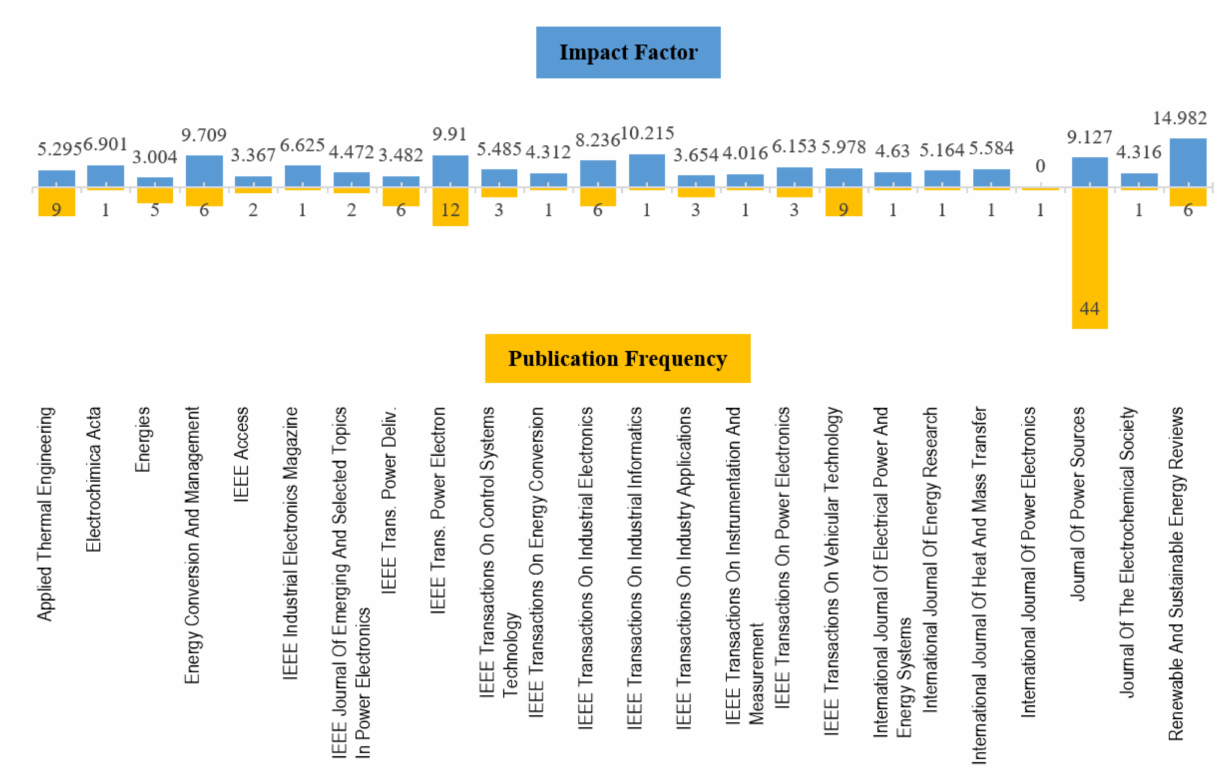
Figure 7. Distribution of 110 most cited research articles, indicating journal of impact factor and